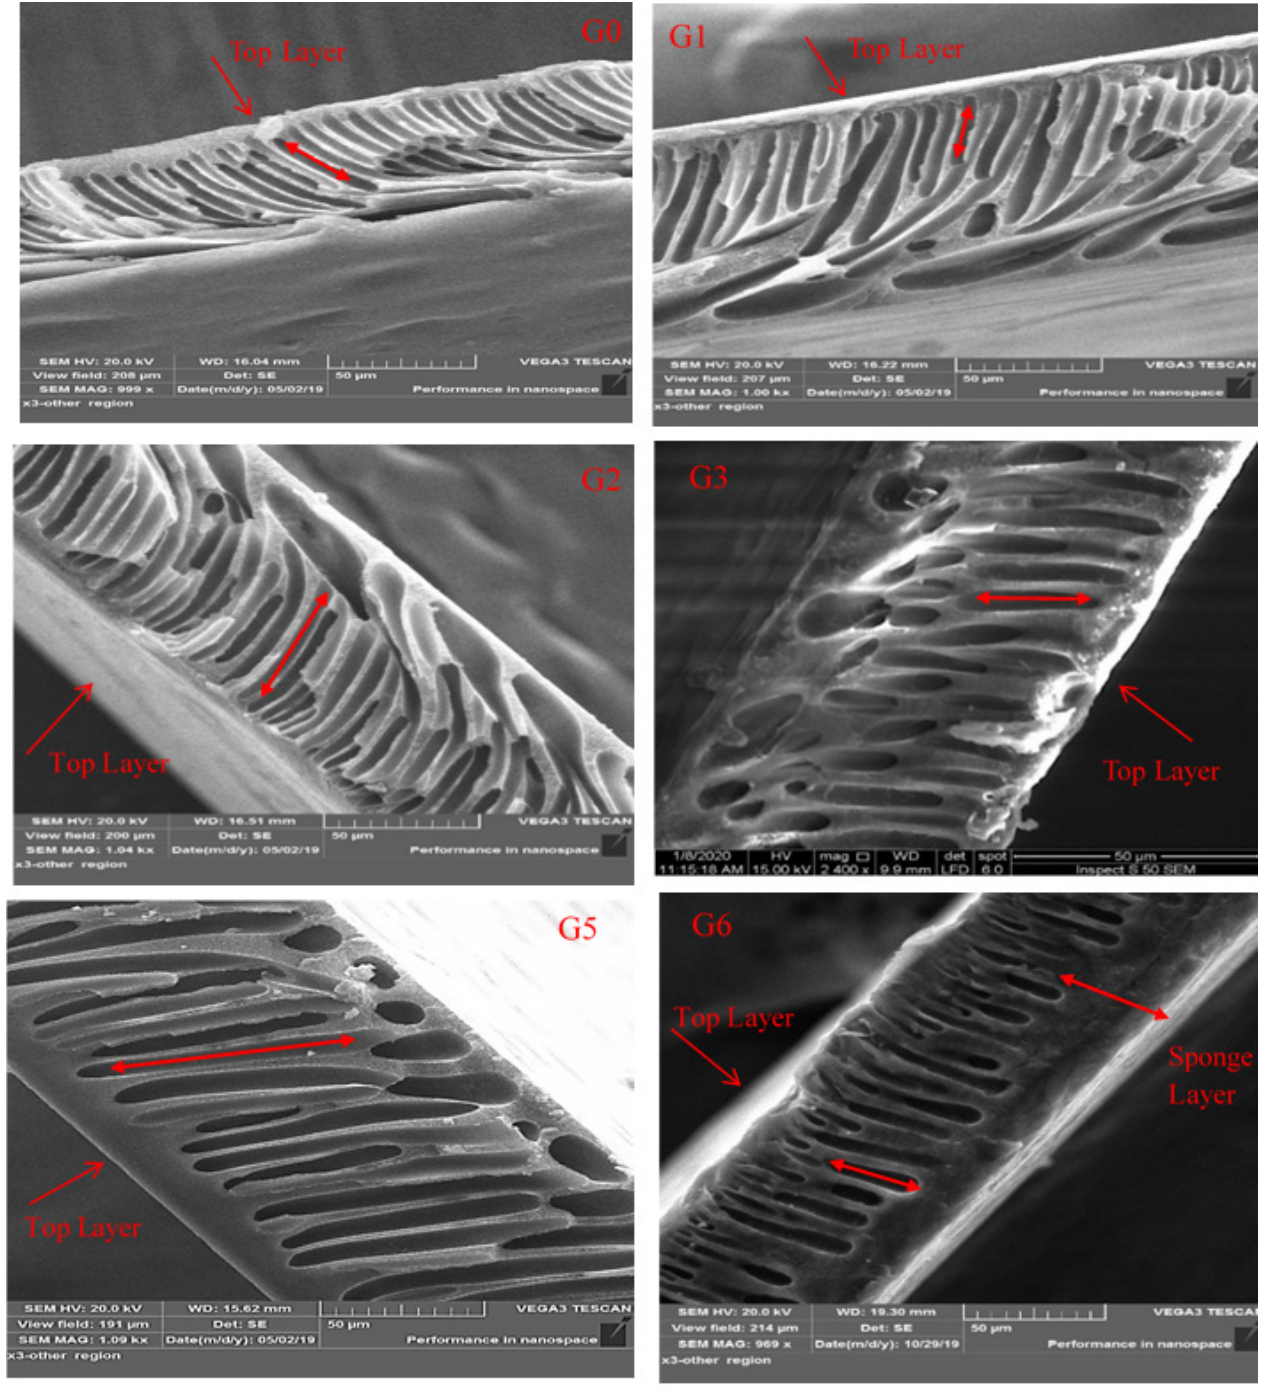
Figure 6. SEM images for the cross-section structures of the neat and PES/TGF membranes with various contents of TGF nano-polymer (( G0 ) 20/0, ( G1 ) 20/1, ( G2 ) 20/2, ( G3 ) 20/3, ( G5 ) 20/5, ( G6 ) 20/6).